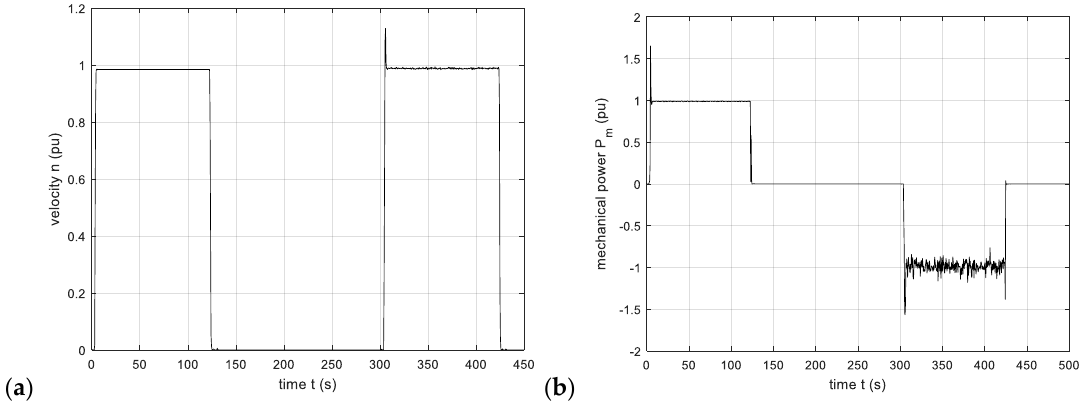
Figure 16. The velocity ( a ) and mechanical power ( b ) measured on the motor shaft during emulation of the work cycle consisting of lifting and lowering the constant weight, defined in per-unit system (p.u.).